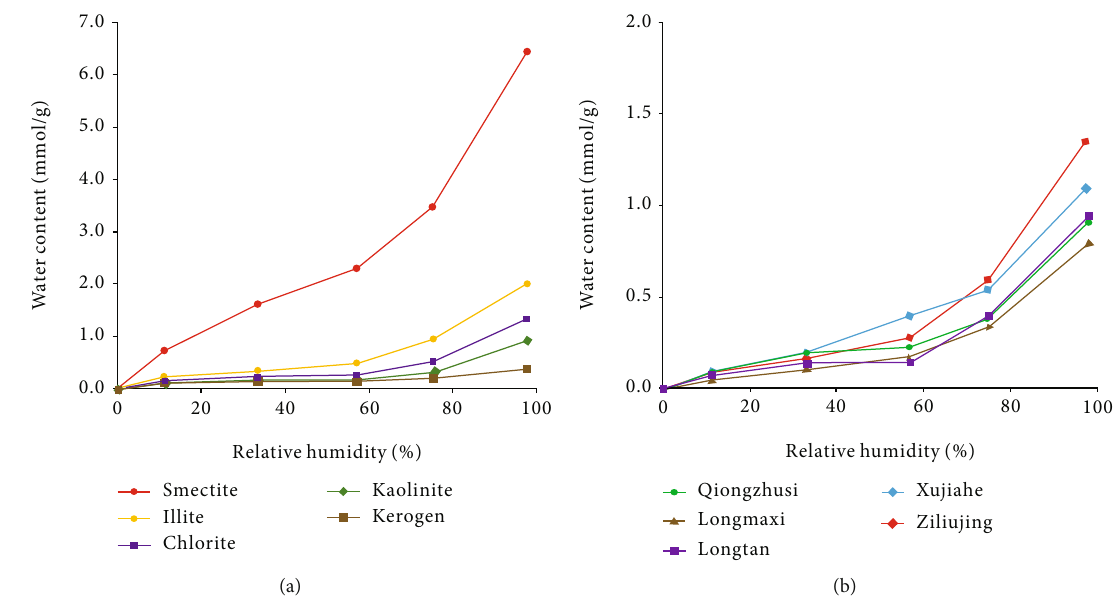
Figure 10: Water absorption capacity of di ff erent clay minerals and di ff erent shales. (a) The relationship between the water content of clay minerals and the relative humidity. (b) The relationship between water content of shale and relative humidity.